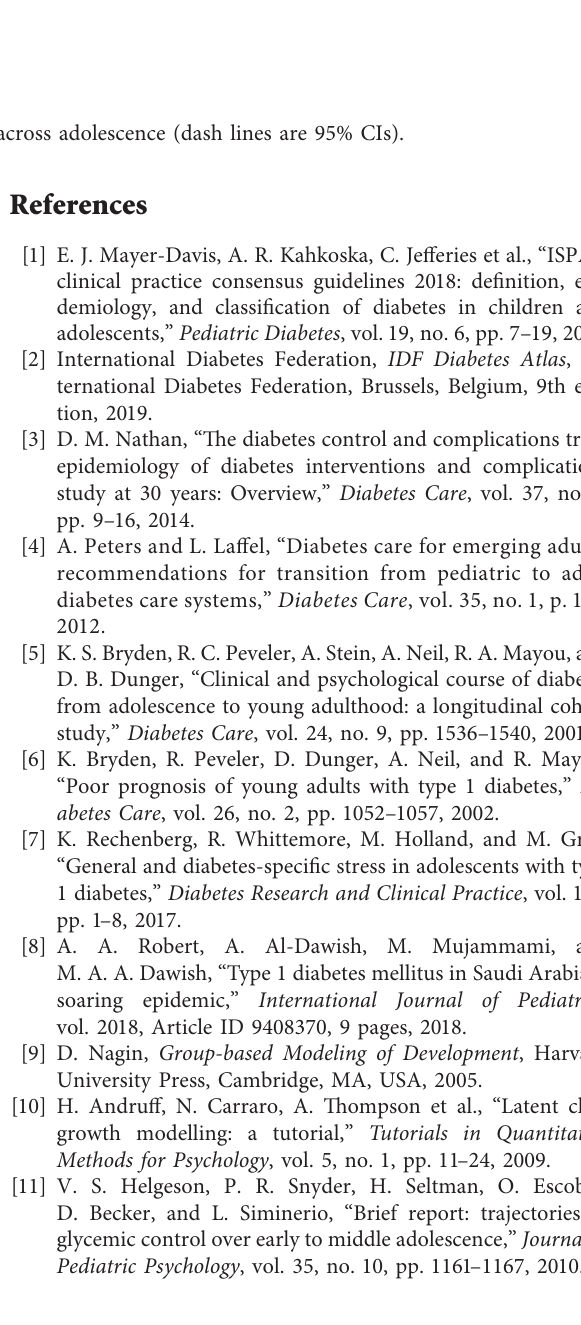
Table 3: descriptive statistics (mean [SD]) of continuous demographic variables according to each trajectory group. Table 4: frequency counts (%) of categorical demographic variables according to each trajectory group. Figure 1: longitudinal trajectories of HbA1c values across adolescence (dash lines are 95% CIs); Group 1 accounts for 71.8% of the subjects and Group 2 accounts for 28.2% of the subjects. Supplement table 1: data extraction sheet and Supplement 2: detailed trajectory results. ( Supplementary Materials )